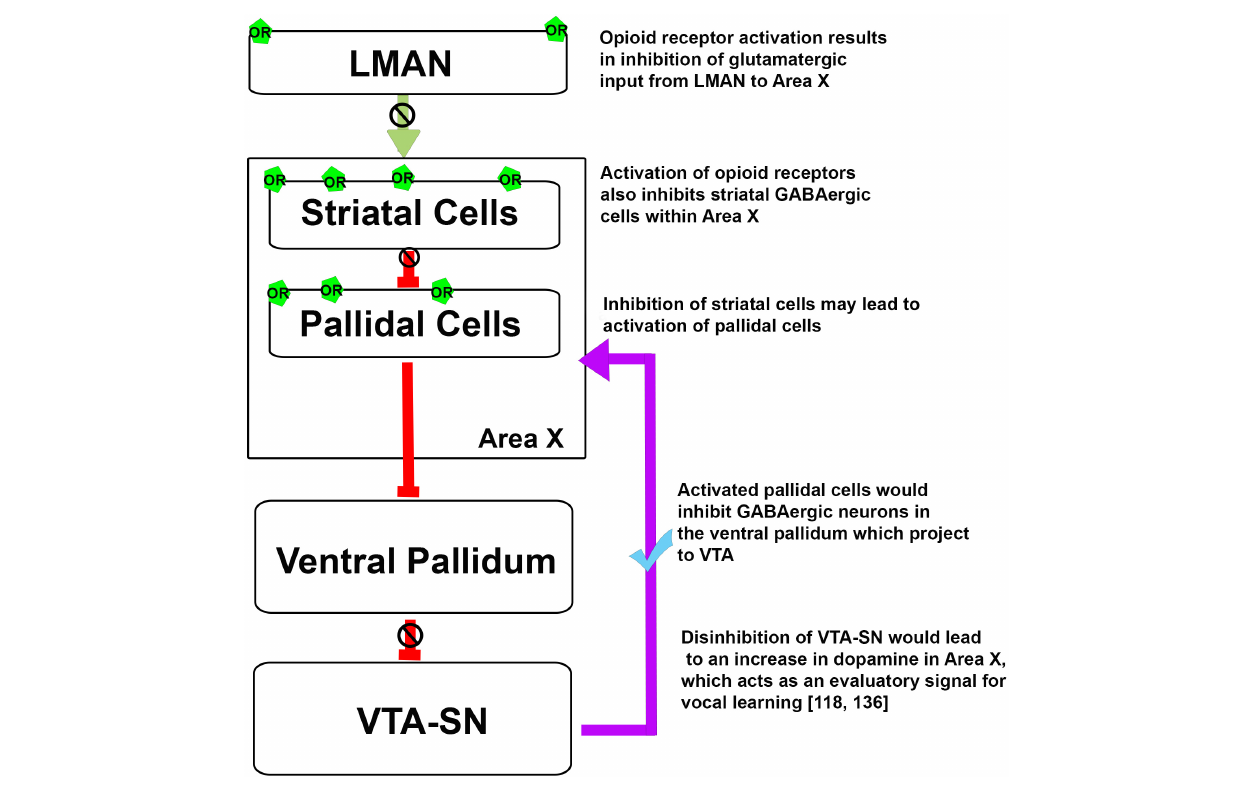
FIGURE 3 | Possible mechanism for the opioid modulation of dopaminergic input to Area X and the regulation of vocal learning. Green arrow, Glutamatergic projection; red arrows, GABAergic projections; violet arrow, dopaminergic projection, OR, opioid receptors.